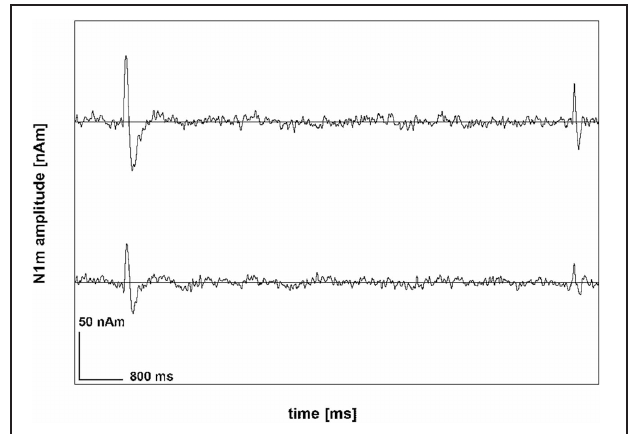
FIGURE 2 | Source space projection applied to the grand average of one representative participant. The signal was highpass-filtered at 1Hz and lowpass-filtered at 30Hz and exhibits prominent onset and offset N1m